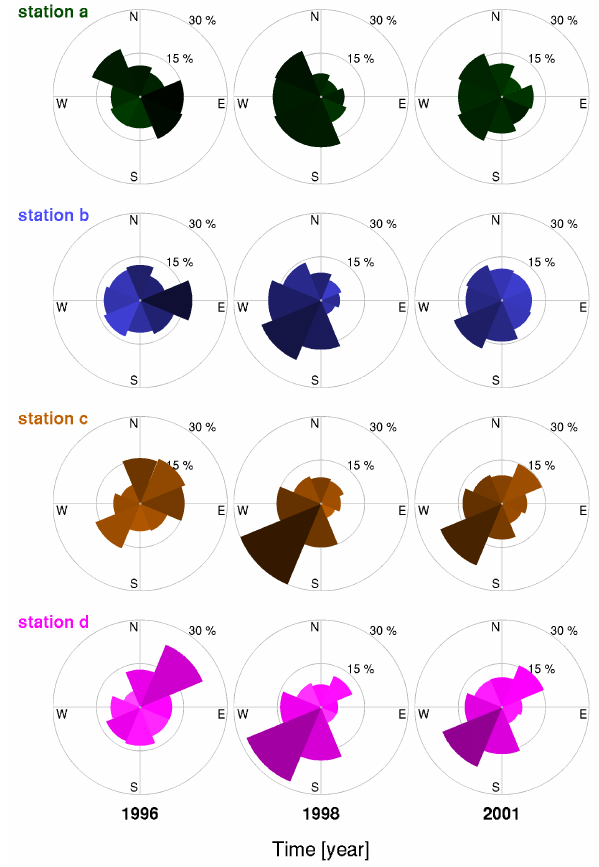
Figure 9. Wind speed and direction at the different stations (see Fig. 8) for 1996 (left), 1998 (middle) and 2001 (right) over the 8 months over which the particle drift was computed, starting with December of the previous year, while finishing in July. The size of the pie-pieces is defined by the percentage of time that the wind is coming from this direction. The colour of the pieces indicates the average wind